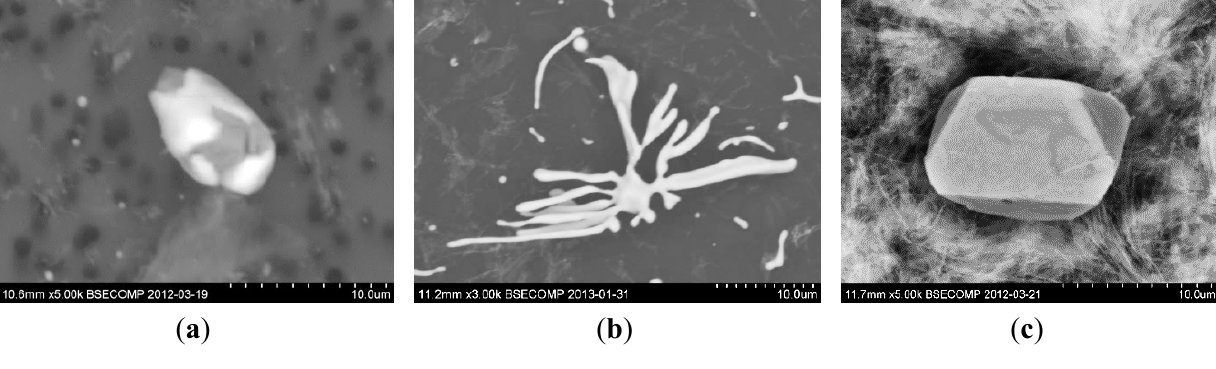
Figure 13. Typical morphology of different sulfides. ( a ) Type I oxy-sulfide; ( b ) Type II (+IV) eutectic MnS; ( c ) Type III regular MnS